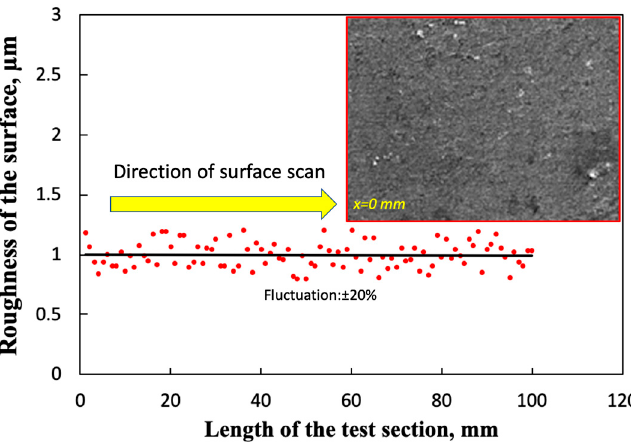
Figure 3. Plot of surface roughness vs. test section length (at the area where the bubble are formed). Inset: Scanning electron microscopy taken from the initial section of the surface.